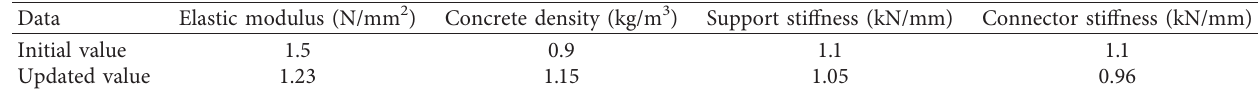
Figure 19: Multiple parameter model updating based on dynamic data: (a) variation of updating parameters; (b) variation of objective function. Table 5: Comparison of initial values and updated values.